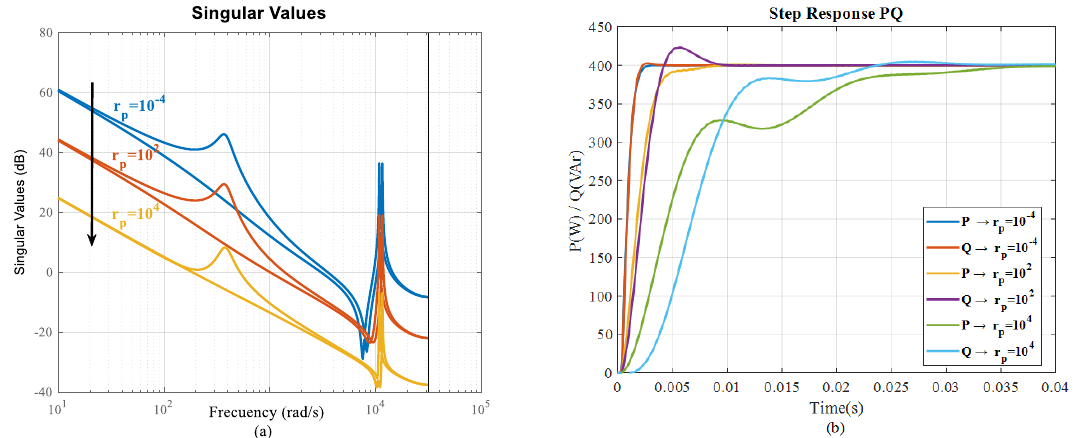
Figure 19. Performance analysis for the variations in q